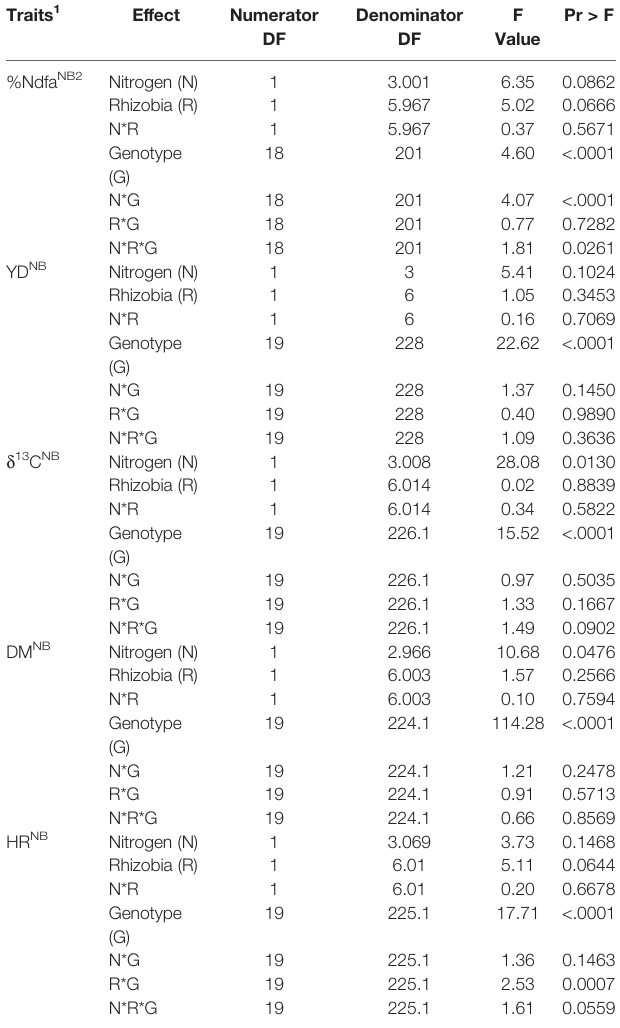
TABLE 1 | Type III tests of fi xed effects from restricted likelihood analysis of split- split plot experiments with 20 common bean genotypes conducted at the Elora research station (ON, Canada) on created K-P land in 2016.